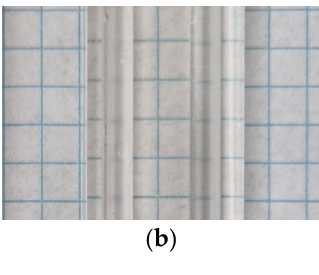
Figure 2. ( a ) Yellowing effect and ( b ) clear